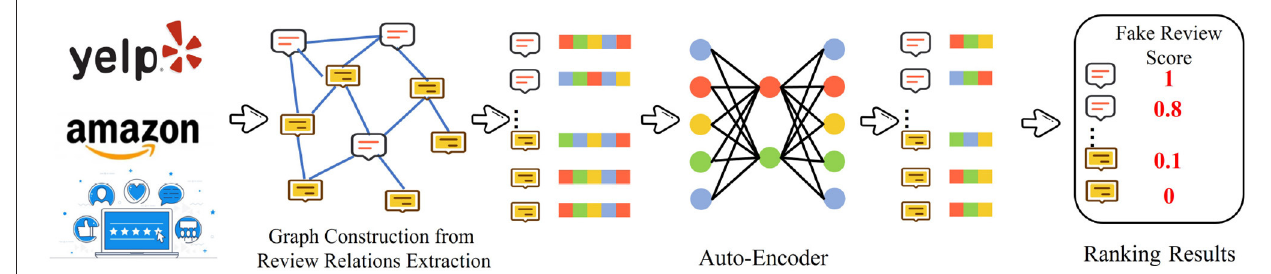
FIGURE 4 | Generation-based methods with Auto-Encoder for fake review